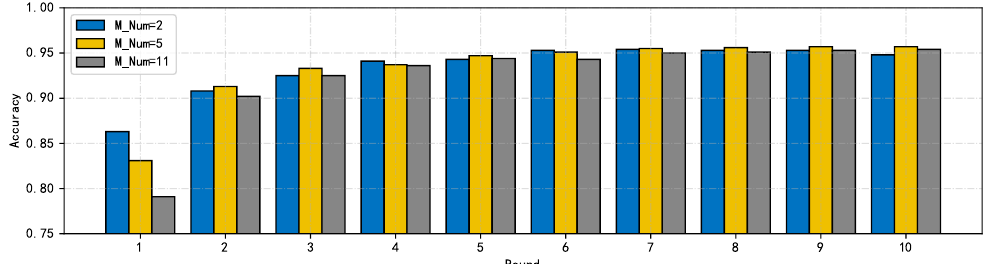
Figure 8. Changes in accuracy of MDIFL with different numbers of